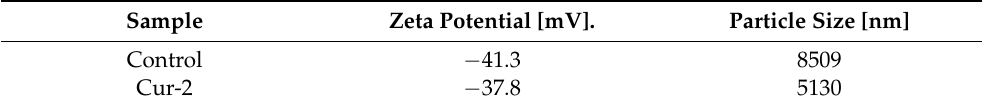
Table 6. Particle/aggregate sizes (DLS) and zeta potential of the control film and the Cur-2 film. Sample Zeta Potential [mV]. Control